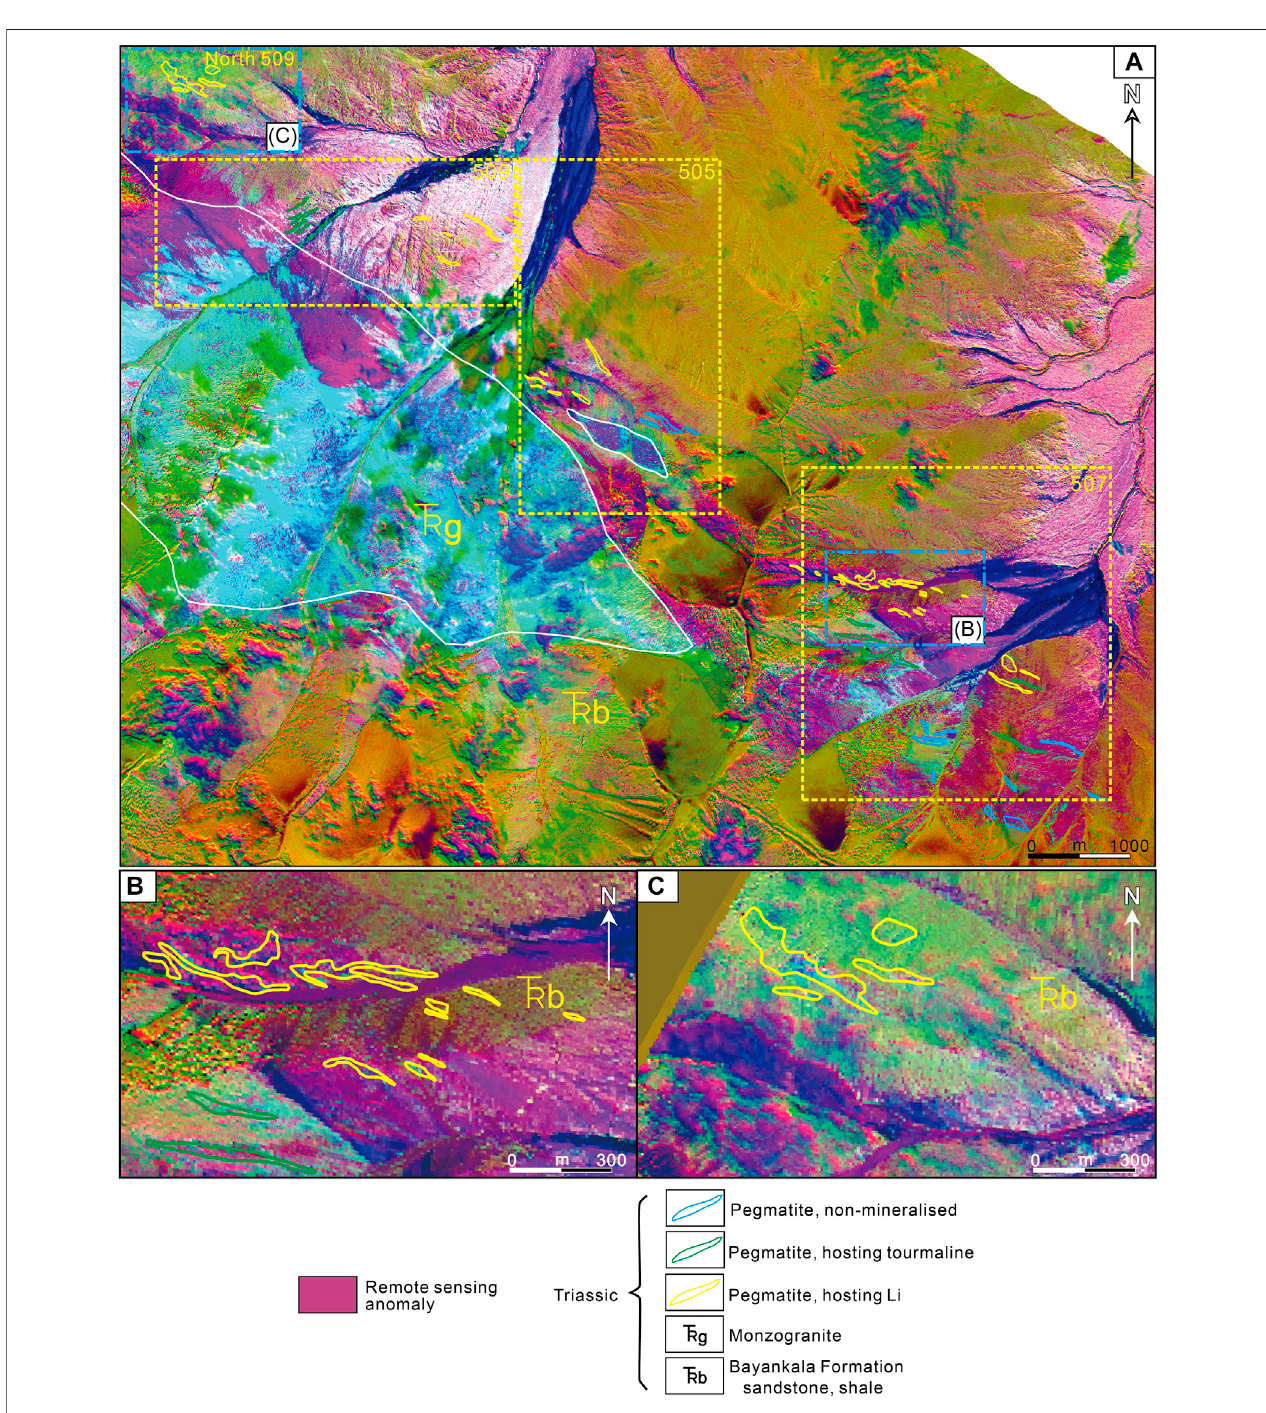
FIGURE14| Worldview-3Remotesensinganomaliesinthe505and507Lidepositsandsurroundingareas: (A) thewholearea; (B) the507Lideposit;and (C) the potential area for Li mineralisation in the North 509 area.